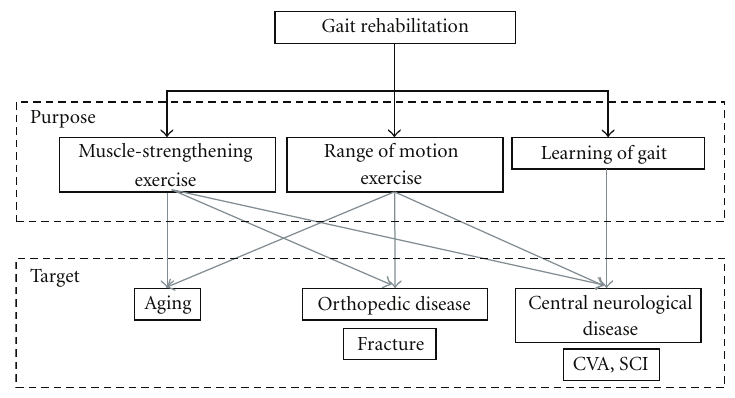
Figure 1: Purpose and target of gait